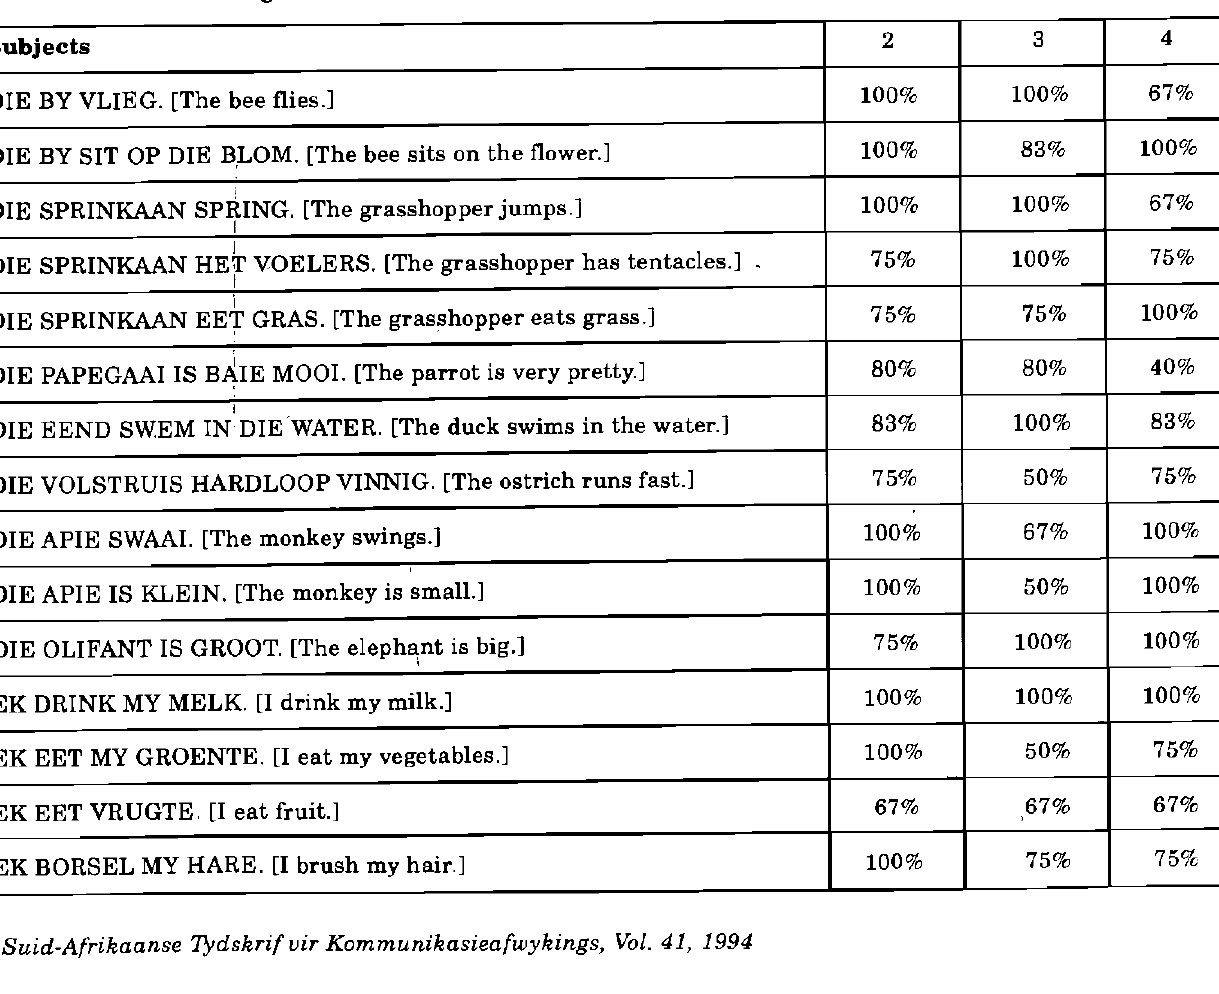
Table 5: Sentence reading after 6 months